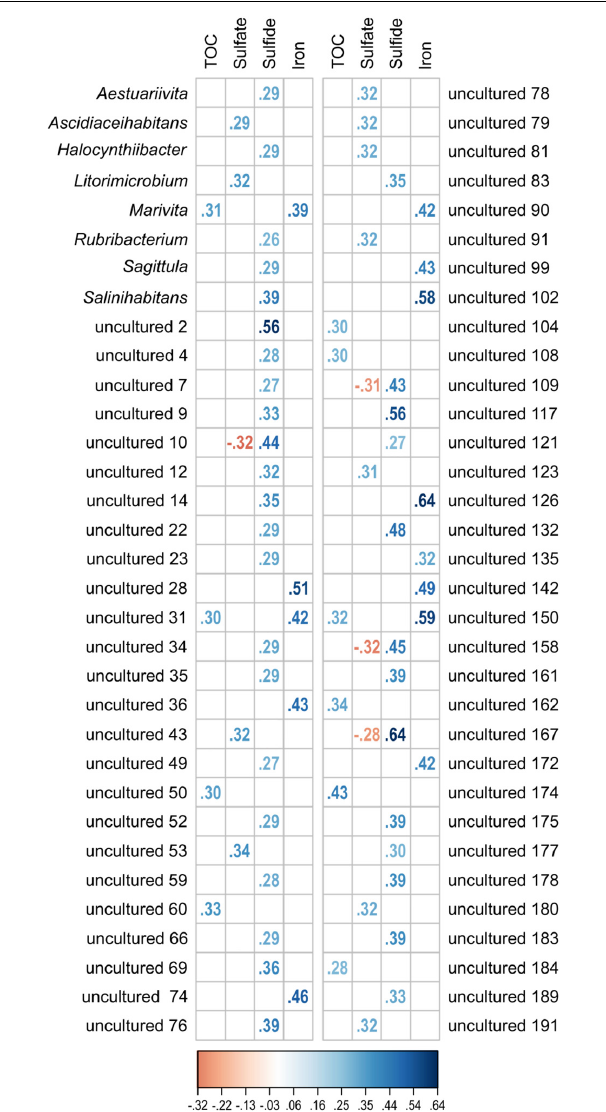
FIGURE 7 | Significant correlation ( p ≤ 0.05) of single OTUs to the environmental parameters TOC, sulfate, sulfide, and iron (Fe 2 + ). All OTUs related to cultured and uncultured Rhodobacteraceae were included in the analysis. Displayed are the Spearman’s rank correlation coefficients ( r s ). While increasing blue colors show positive correlations, red colors indicate negative